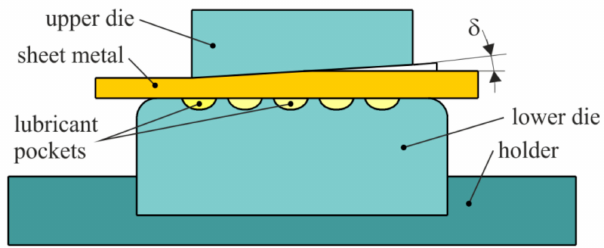
Figure 13. Schematic diagram of an SRT with a textured tool surface, prepared based on [62].